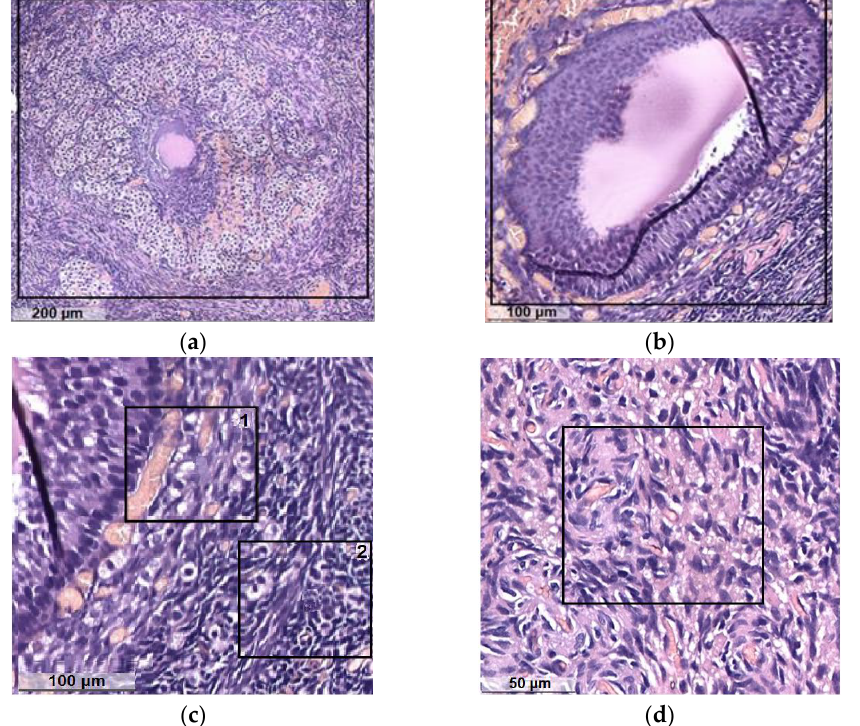
Figure 7. Histology of clinically healthy cat ovaries in the luteal phase: ( a ) corpus luteum; ( b ) atretic follicle; ( c ) follicular theca with an abundance of blood vessels: 1 — internal, 2 — external; ( d ) interstitial connective tissue.